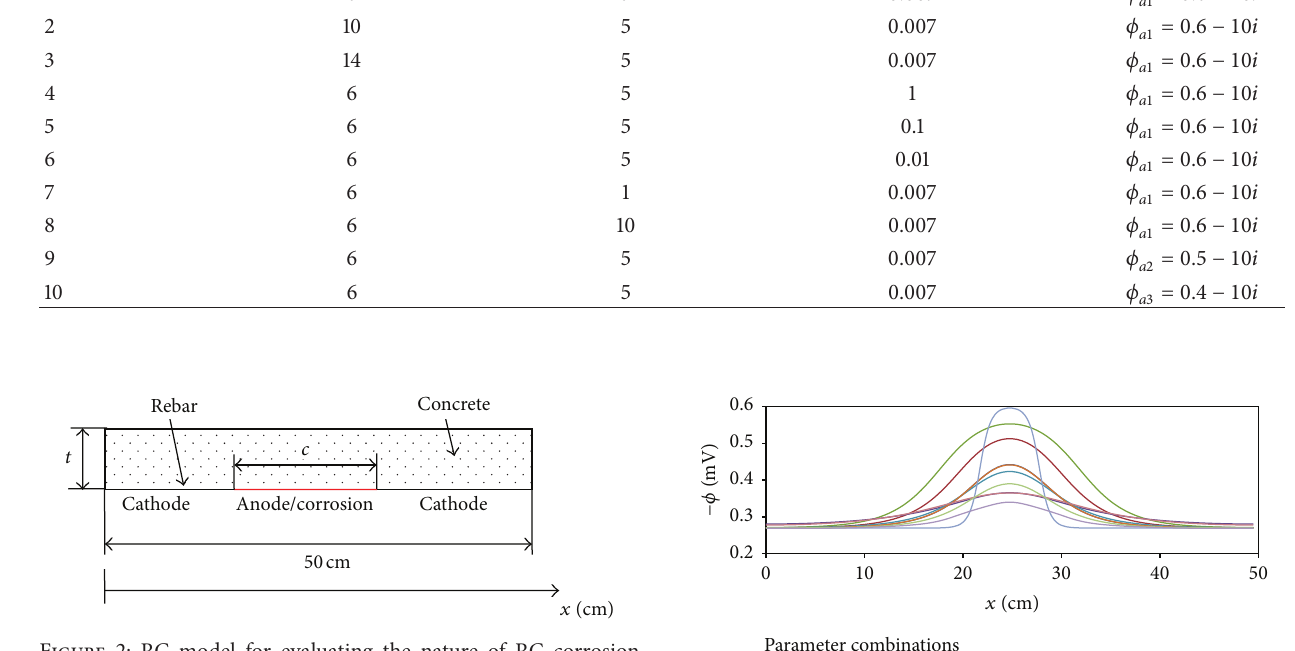
Figure 2: RC model for evaluating the nature of RC corrosion detection problem.